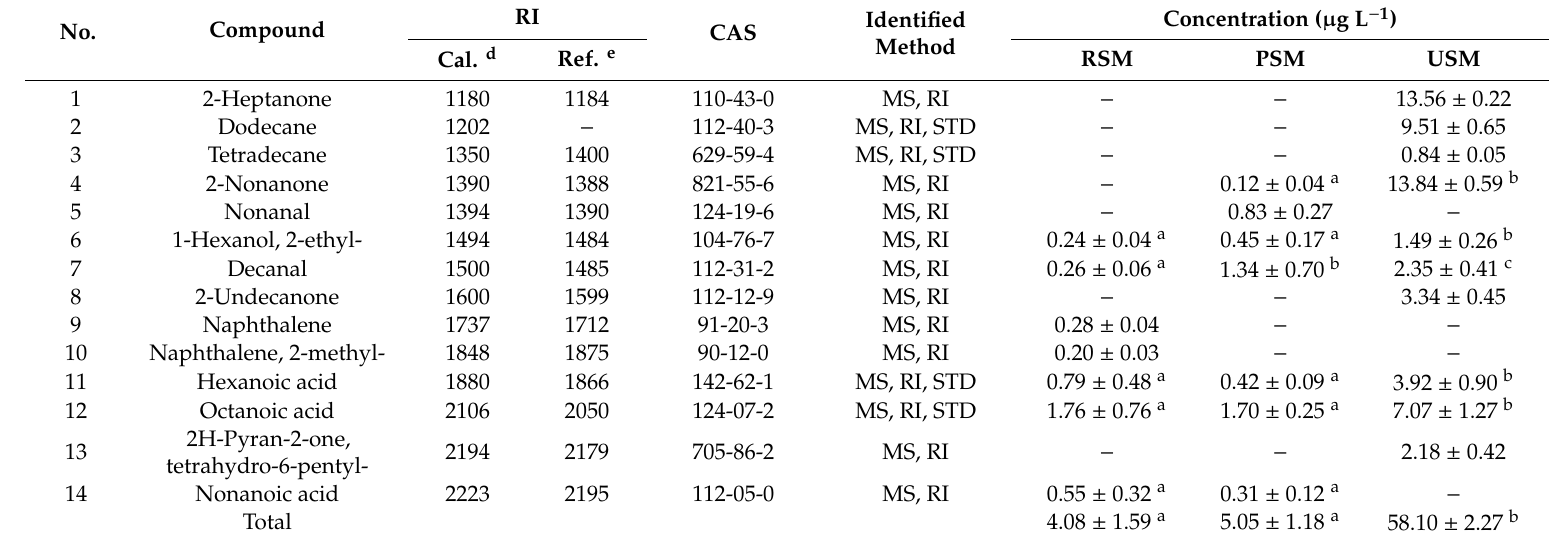
Table 2. HS-SPME-GC-MS analytical results for the volatile compounds of three kinds of skim milk